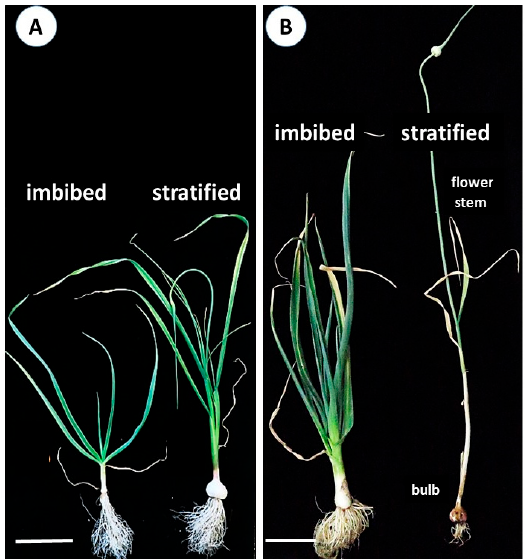
Figure 3. Effect of seed stratification on the phenotypic expression of garlic seedlings. Seeds were either imbibed for eight hours or stratified for eight weeks at 4 °C prior to sowing in November 2018. ( A ) Five-month old plants raised from imbibed and stratified seeds, March 2019, bar = 7 cm. ( B ) Seven-month old plants, May 2019. Plants from imbibed seeds had 14–15 foliage leaves, no flower stem and / or bulb; stratified plants at the end of their annual cycle had dried-out leaves, with a defined bulb, elongated flower stem, and developed inflorescence. Bar = 10 cm.